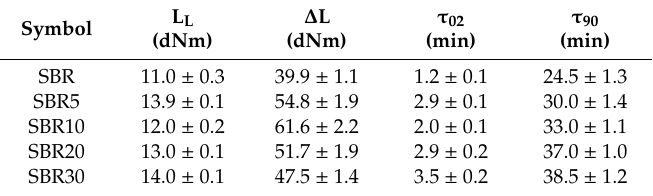
Table 2. Influence of BDC on the rheometric properties of SBR compounds.